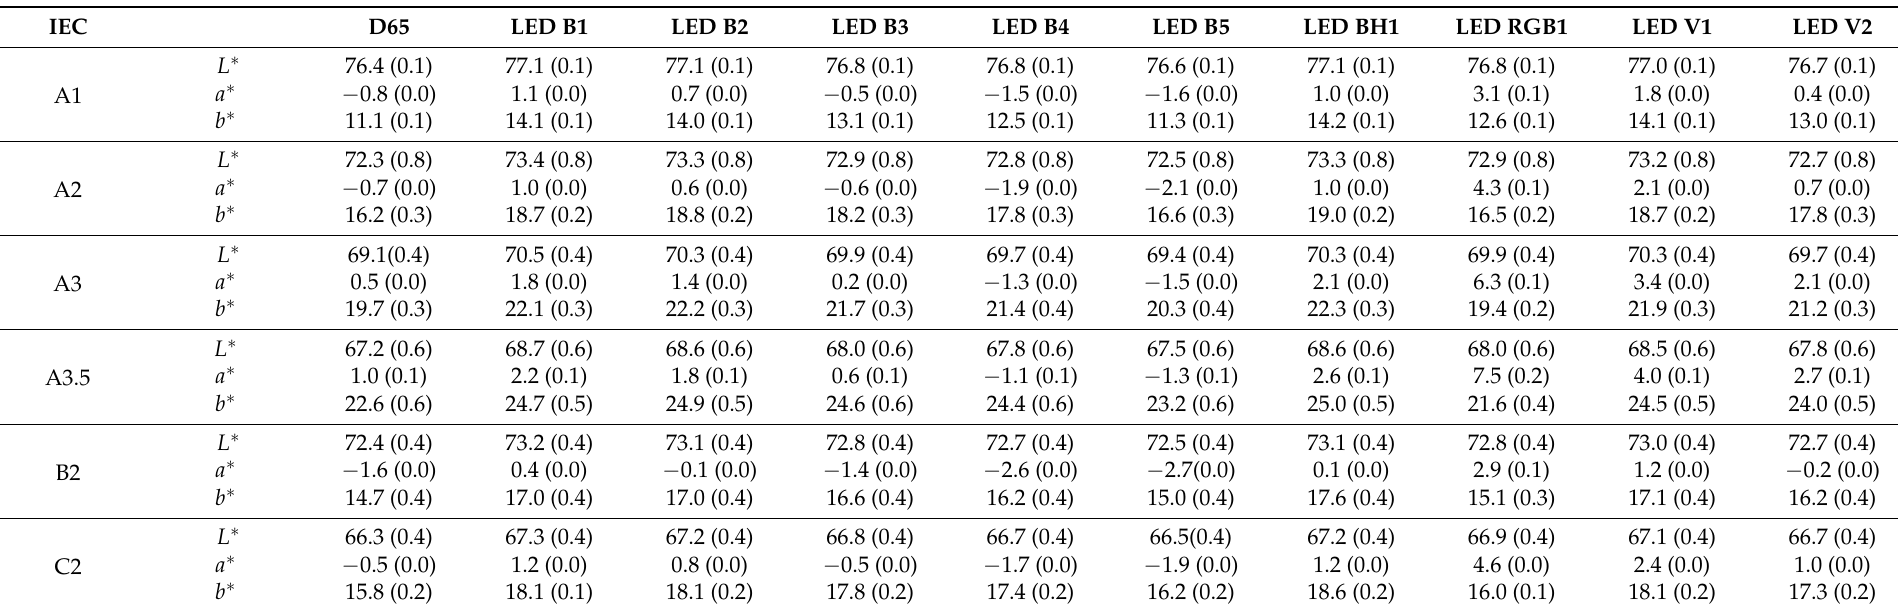
Table 4. Mean CIELAB color coordinate values and standard deviations (in parentheses) for the IEC ceramic shades under D65 and nine LED illuminants (corresponding colors under D65 illuminant and CIE 1931 standard colorimetric